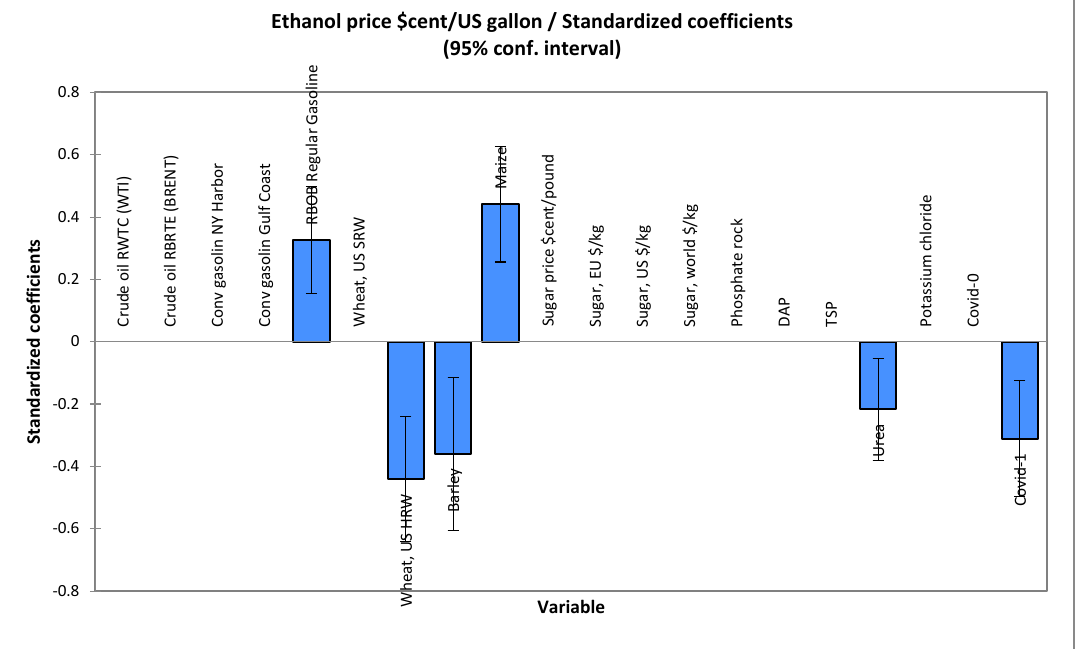
Figure 10. Impacts of the significant variables on the ethanol price with COVID. Note: The blue bars show the average values, while their lines indicate the minimum/maximum intervals of the coefficients analyzed.